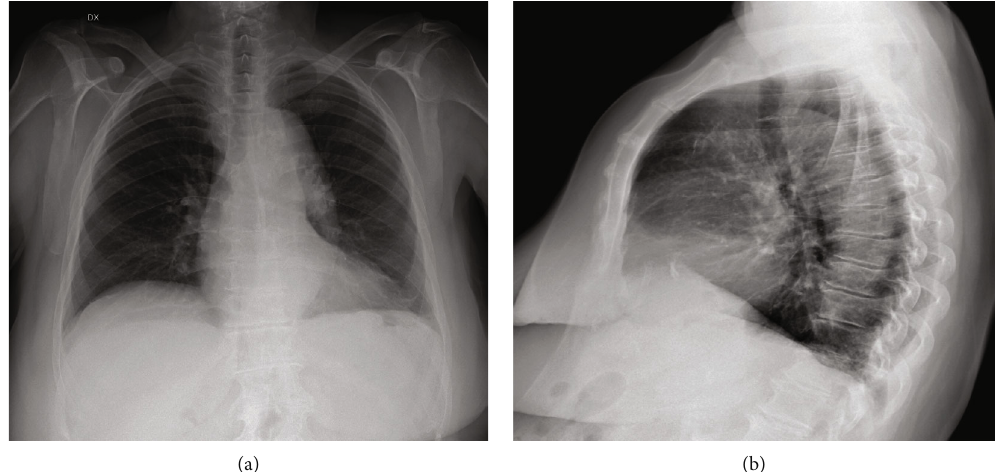
Figure 1: Chest radiograph in posteroanterior (a) and lateral (b) view: nothing abnormal detected.